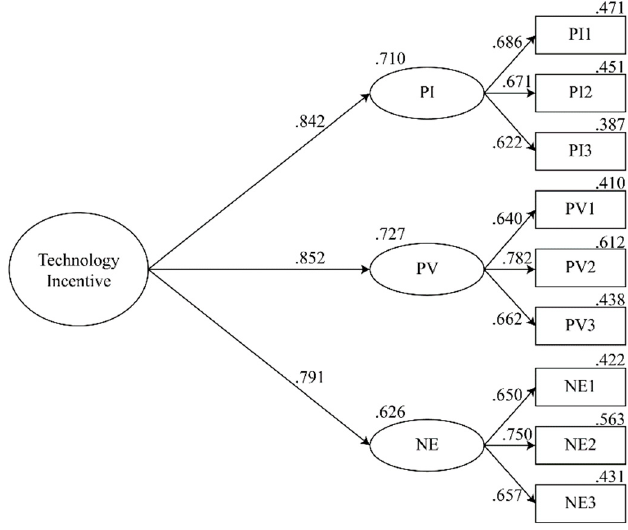
Figure 3. CFA second order results.